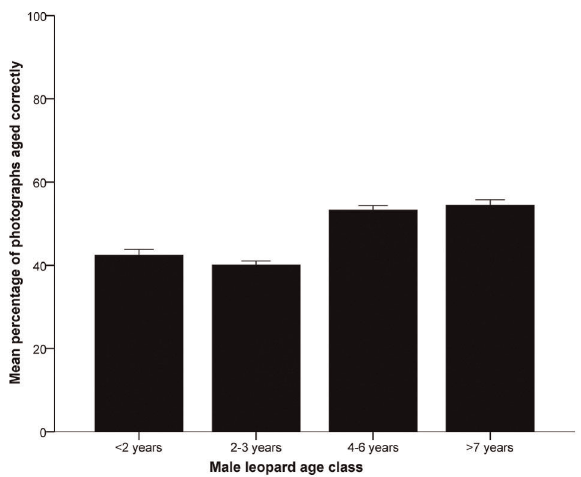
Figure 3. Mean percentage of male leopard photographs assigned to their correct age classes by survey respondents. Bars show standard error (n = 225).